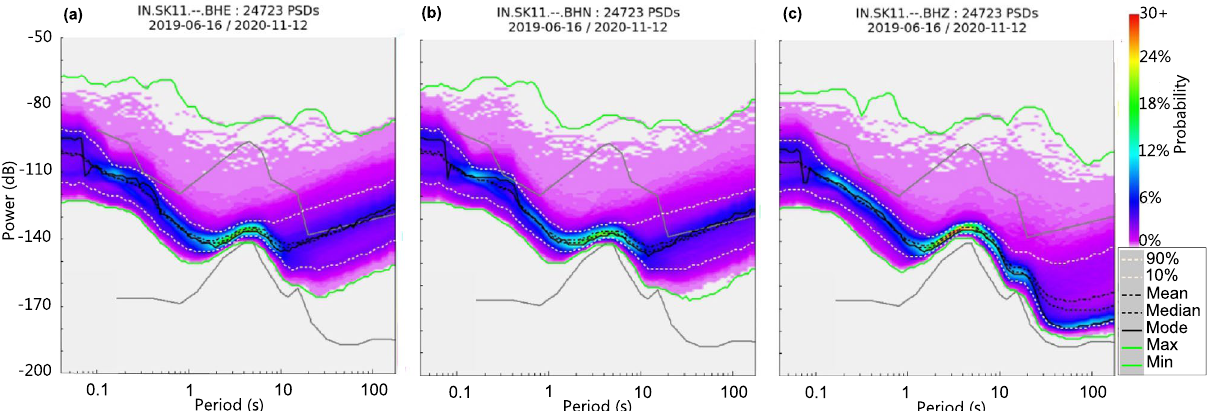
Figure 3. Power Spectral Density (PSD) of ( a ) E-component, ( b ) N-component and ( c ) Z-component at station SK11 for the data collected from June 2019 to November 2020. Long-period noise levels are higher in horizontal components (E, N) as compared to the vertical (Z)